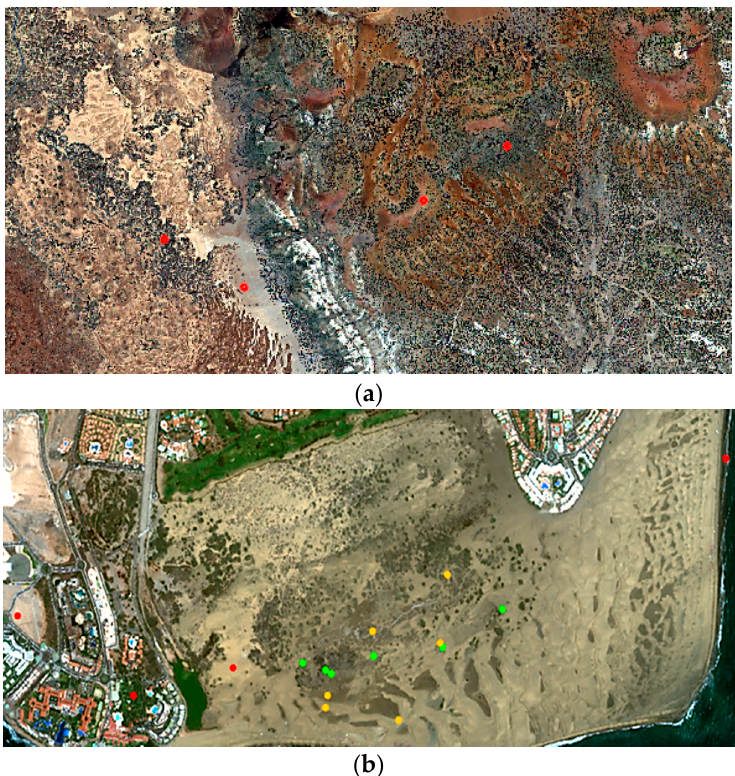
Figure 5. Sites analyzed (red for the relative analysis and green and orange for the absolute evaluation of vegetation and soil points): ( a ) Teide National Park; ( b ) Maspalomas Natural Reserve.